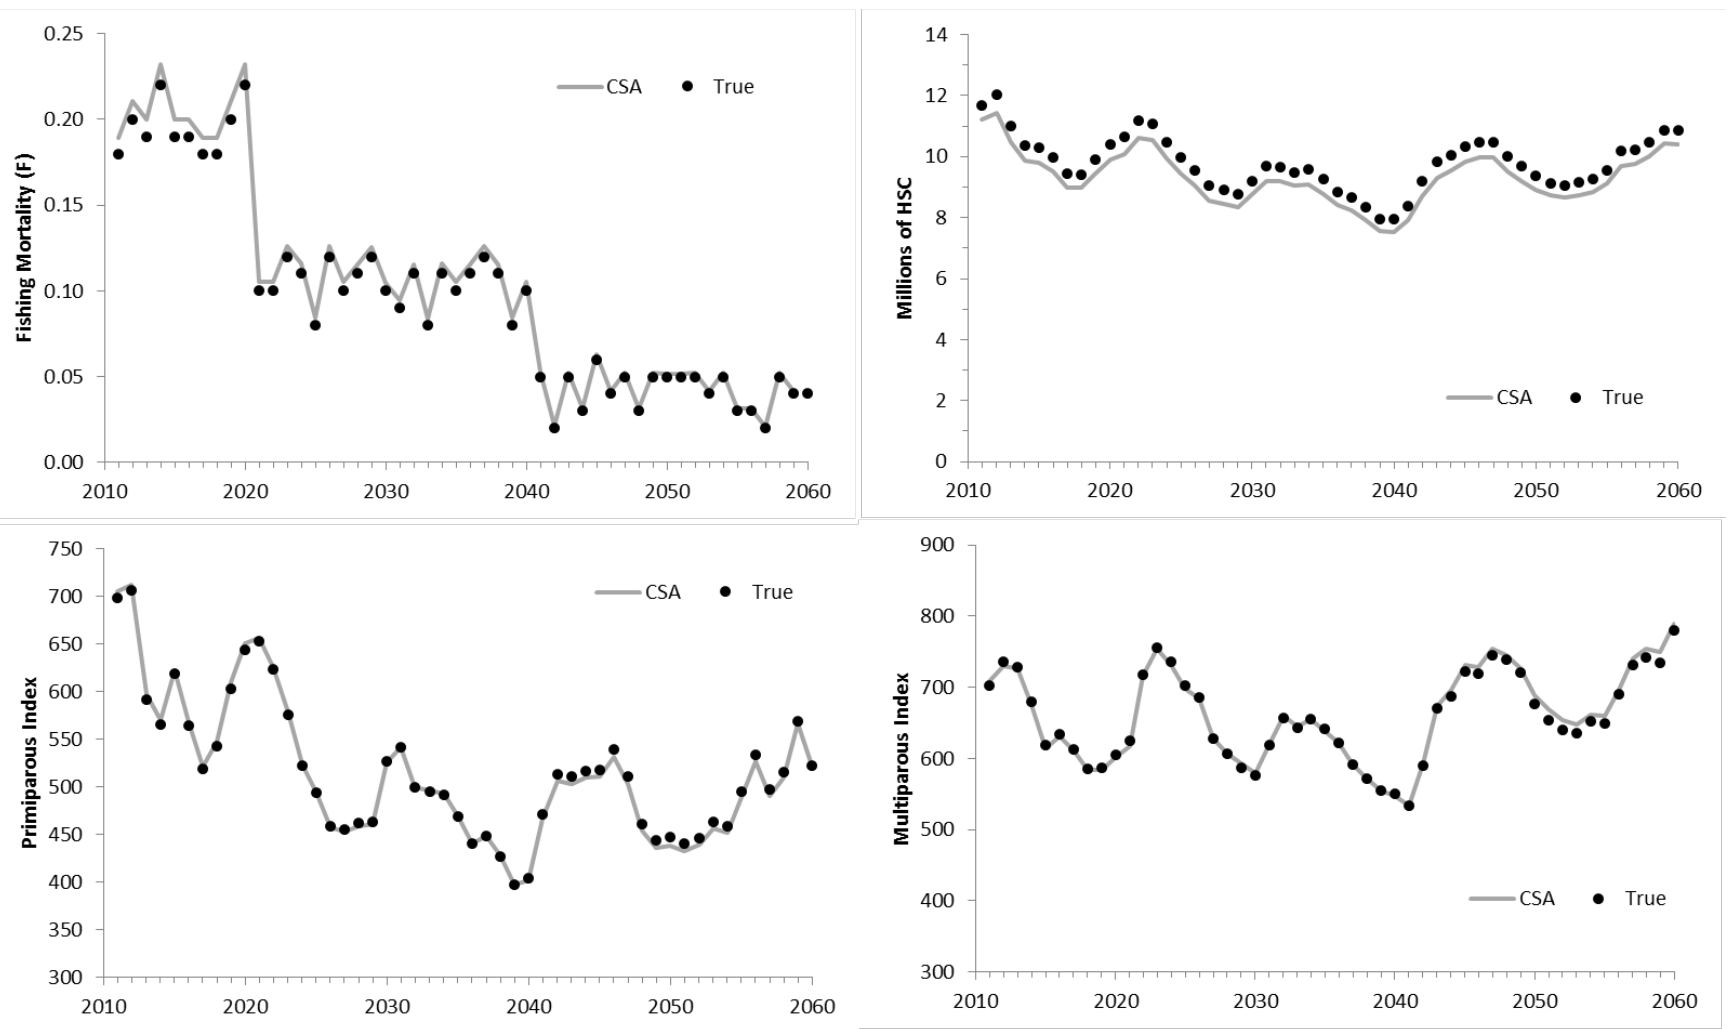
Figure 99. Comparison between simulated “true” data from the operating model and catch survey analysis (CSA) results for simulation